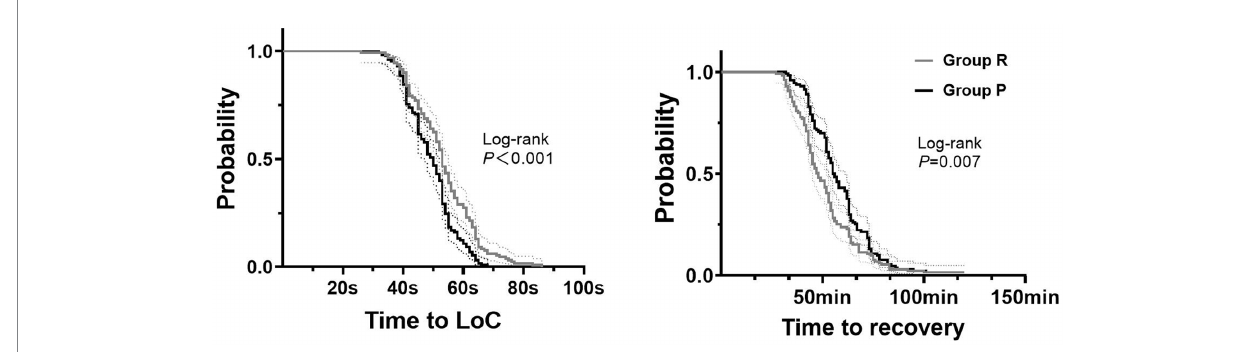
FIGURE 3 Kaplan–Meier curves for time to induction and recovery. 1. Group R = propofol + esketamine group; Group P = remimazolam + esketamine group; 2. Time to Loc: time to loss of consciousness; 3. The dashed lines represent the 95% confidence